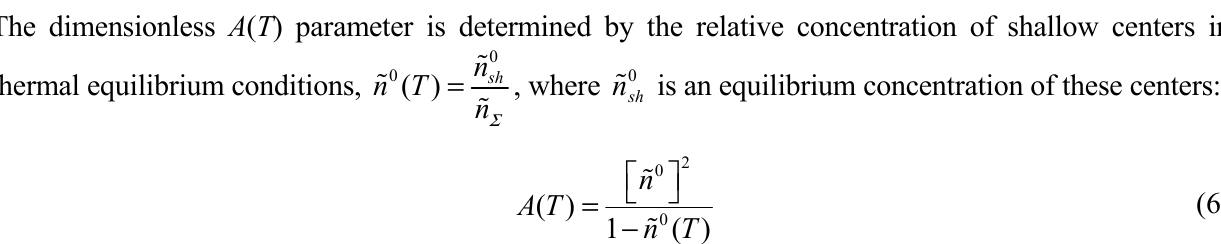
:Ga ( N = 4 × 10 17 cm − 3 ) 2 Ga